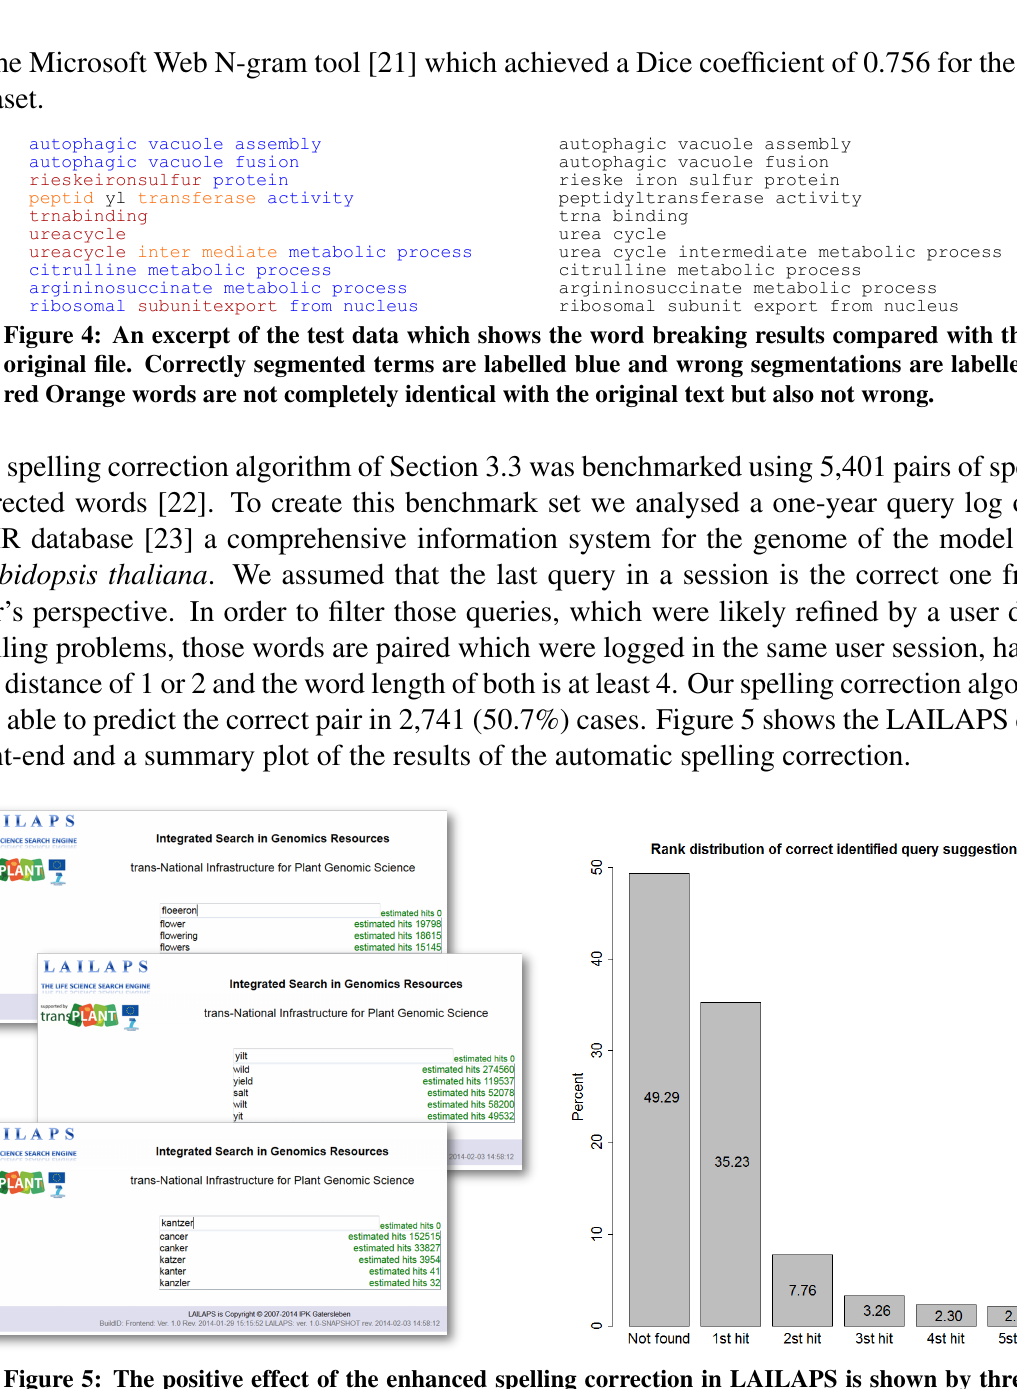
Figure 5: The positive effect of the enhanced spelling correction in LAILAPS is shown by three misspelled keywords: (a) floeeron = flowering represents a typical misspelling caused by hitting neighbouring keys at the keyboard, (b) yilt = yield shows the effect of spelling errors and (c) kantzer = cancer demonstrates language based spelling problems. – The histogram shows the distribution of 5,401 corrected words binned by their position in the suggestion list. For half of all words correct suggestions where under the top five and a fraction of 35% accurately spell corrected words is at the top